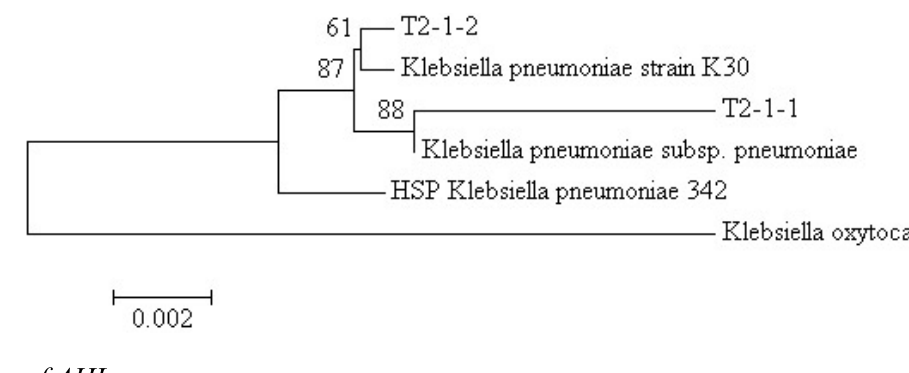
Figure 2. 16S rDNA-based phylogenetic tree showing the phylogenetic positions of oral bacterial isolates T2-1-1 and T2-1-2. A total of 912 unambiguously aligned nucleotides were analysed using MEGA 4. The percentages of replicate trees in which the associated taxa clustered together in the bootstrap test are shown next to the branches. The tree is drawn to scale, with branch lengths in the same units as those of the evolutionary distances used to infer the phylogenetic tree. The bar at the bottom represents evolutionary distance as 0.002 change per nucleotide position. GenBank accession numbers are given in parentheses: K. oxytoca (AB476819), K. pneumoniae subsp. pneumoniae